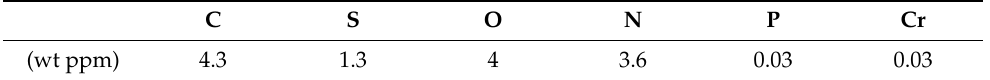
Table 1. Chemical composition of pure EFDA Fe manufactured by